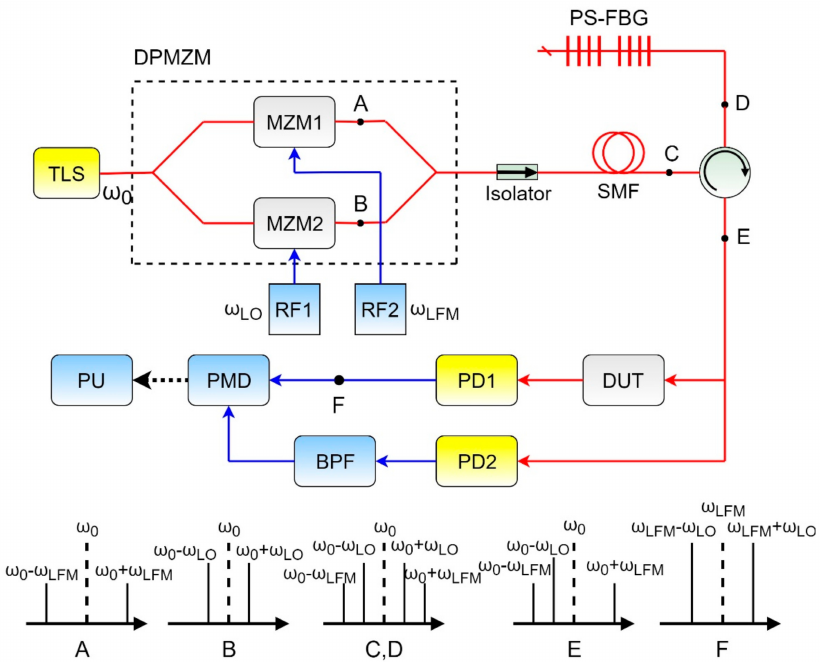
Figure 11. The block diagram of the asymmetric ODSB-based OVA and PS-FBG: TLS—tunable laser source; DPMZM—dual-parallel Mach–Zehnder modulator;